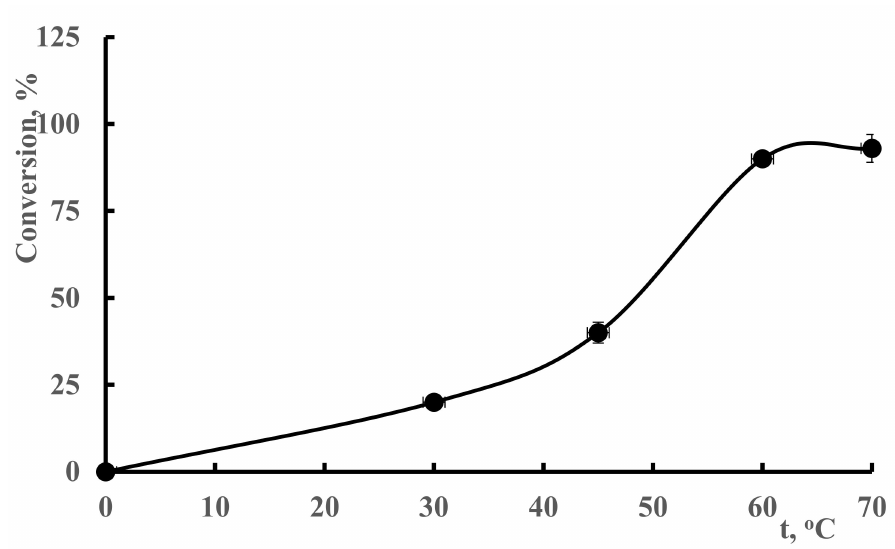
Figure 2. The influence of temperature on conversion of hydrogel